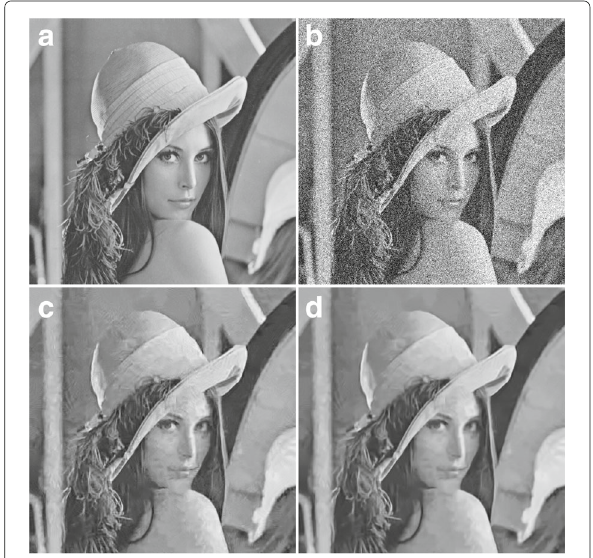
Fig. 5 Subjective assessment between the fast profile of BM3D and the proposed method. a Original image. b Noisy image at noise level σ = 50, PSNR = 14.60, and SSIM = 0.1163. c Output using the normal profile of BM3D, PSNR = 28.28 and SSIM = 0.7438. d Output using the proposed method, PSNR = 28.93 and SSIM =